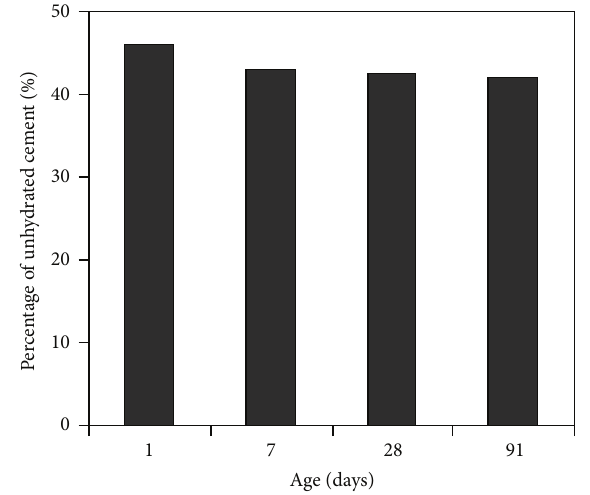
Figure 1: The percentage of unhydrated cement in paste (water to binder ratio: 0.18; sand to binder ratio: 1.0; superplasticizer, solid% by weight of binder: 0.9) [29].